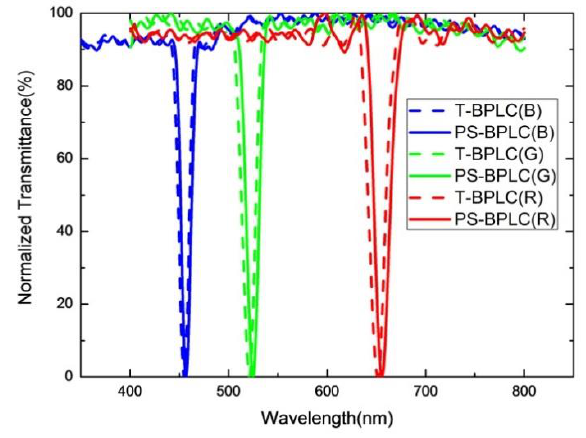
Figure 5. The normalized reflection spectrum of polymer-stabilized blue phase liquid crystals and templated blue phase liquid crystals for blue, green and red colors.